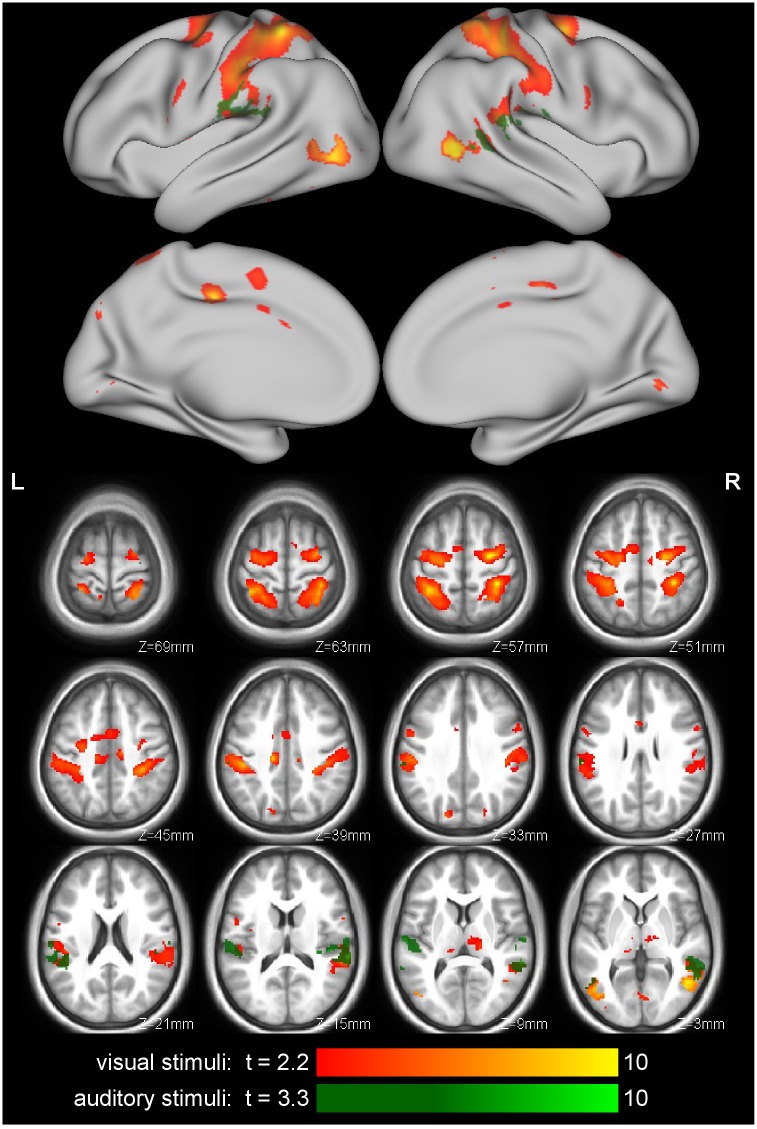
Identification of the shared circuits, by means of the mass-univariate GLM.Shared voxels resulting from the contrast (Action Movies)–(Control Movies), limited to the execution mask (p < .05 FDR correction, minimum cluster size 10 voxels) are shown in orange, with cluster sizes and coordinates are listed in Table 2. Shared voxels for the auditory stimuli, (Action Sounds)—(Control Sounds), (p < .05 FDR correction, minimum cluster size 10 voxels), limited to the execution mask are shown in green.